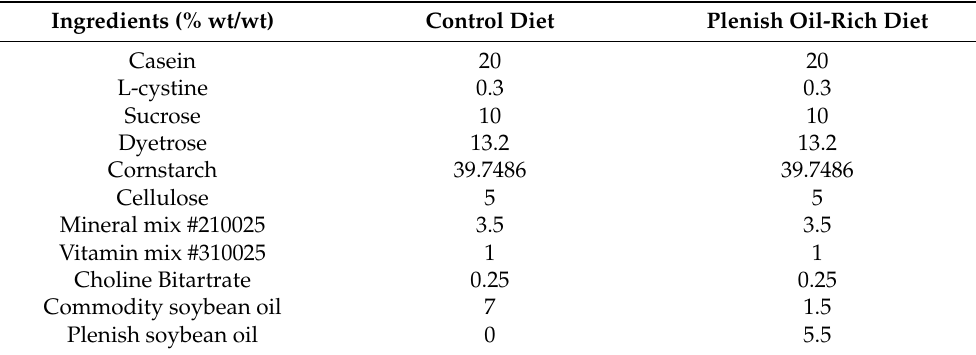
Table 1. Composition of the experimental diets.